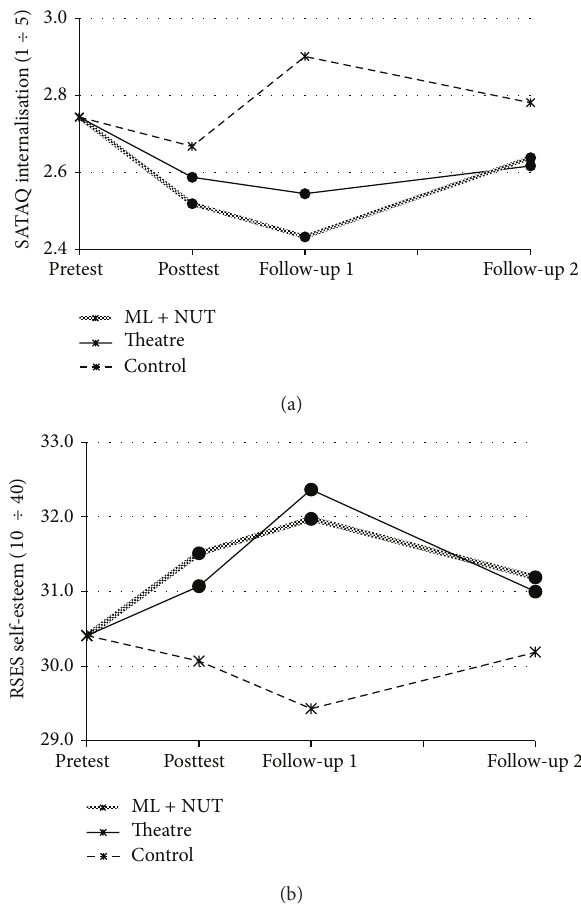
Figure 2: Profiles for statistically significant comparisons among groupsforSATAQ-Rinternalization(a)andRSESself-esteemscores